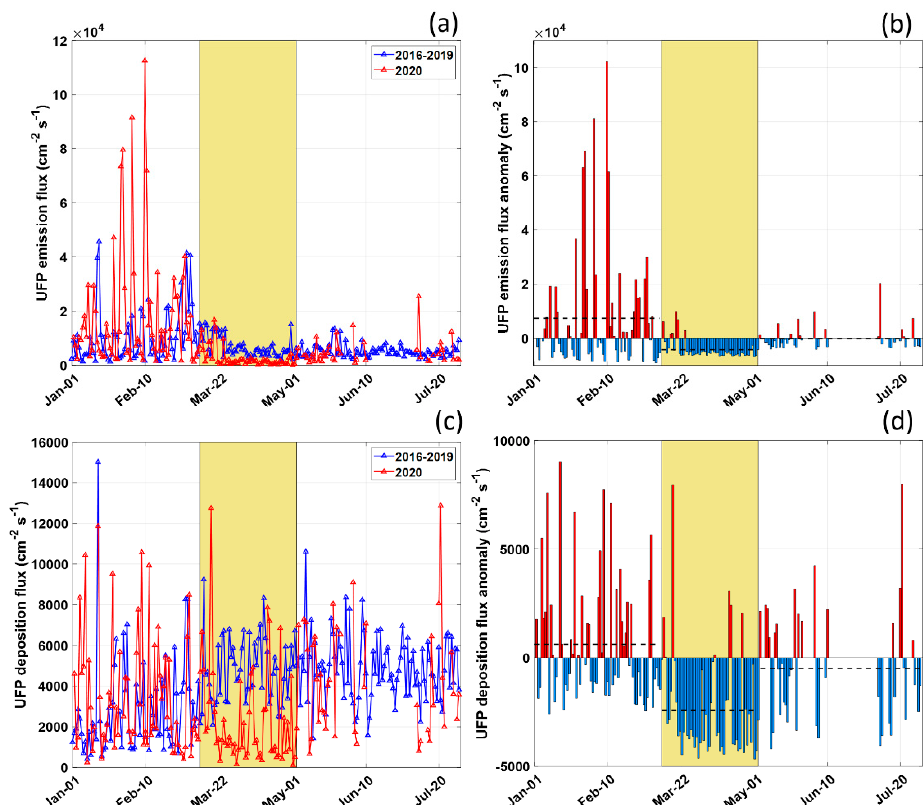
Figure 8. Time series of daily UFP ( a ) positive (emission) and ( c ) negative (deposition) fluxes for the measurement period from January to July 2020 and the corresponding period in the years 2016–2019. Anomalies for each day are calculated from the difference with a baseline value (mean positive/negative flux level for each phase of the period 2016–2019) for ( b ) emission and ( d ) deposition fluxes. The lockdown period is evidenced by a yellow band.